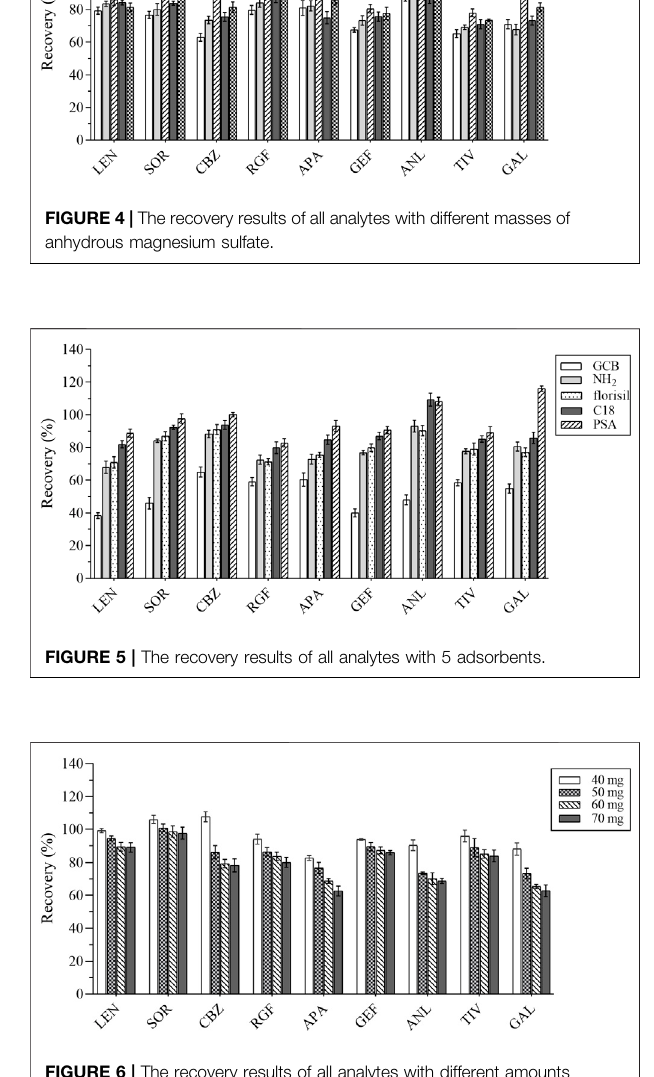
FIGURE 3 | The recovery results of all analytes with different volumes of acetonitrile.